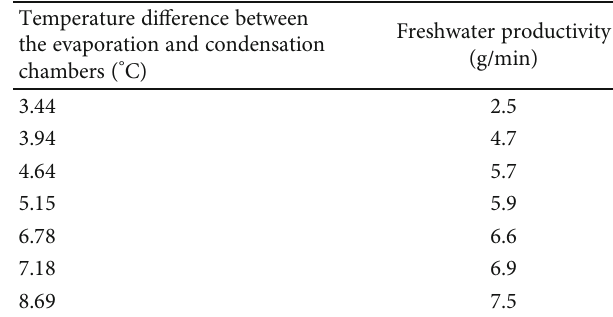
Figure 6: (a) Temperatures in the evaporation and condensation chambers under di ff erent wind speeds without a cooling tower ( T evp denotes the evaporation chamber temperature, T cnd denotes the condensation chamber temperature, and the speed denotes the wind speed); (b) long- term cooling water inlet temperature without the cooling tower; (c) the brine and the cooling water temperatures at the inlets and outlets of the evaporation and condensation chambers with utilization of the cooling tower. Table 3: Freshwater productivities and thermal e ffi ciencies under Table 4: Freshwater productivities under di ff erent temperature di ff erent inlet wind speeds. di ff erences between the evaporation and condensation